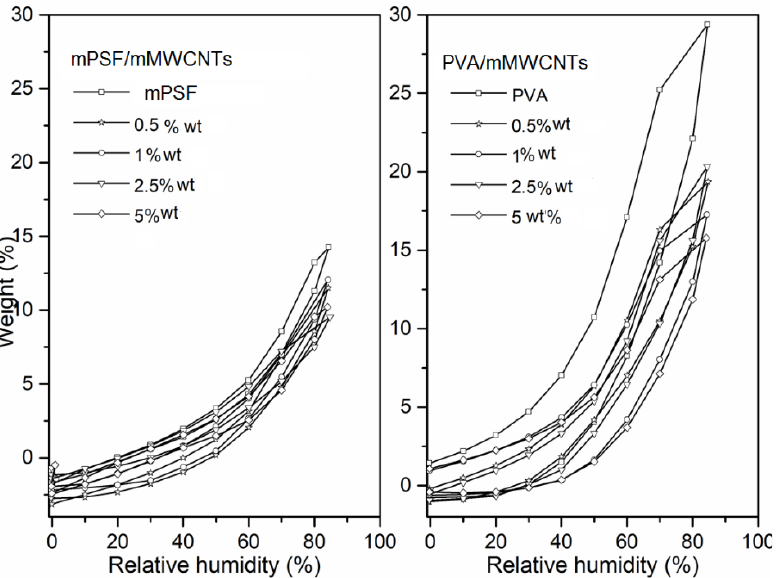
Figure 6. Sorption isotherms for PVA, mPSF, and their composites, PVA/mMWCNTs and